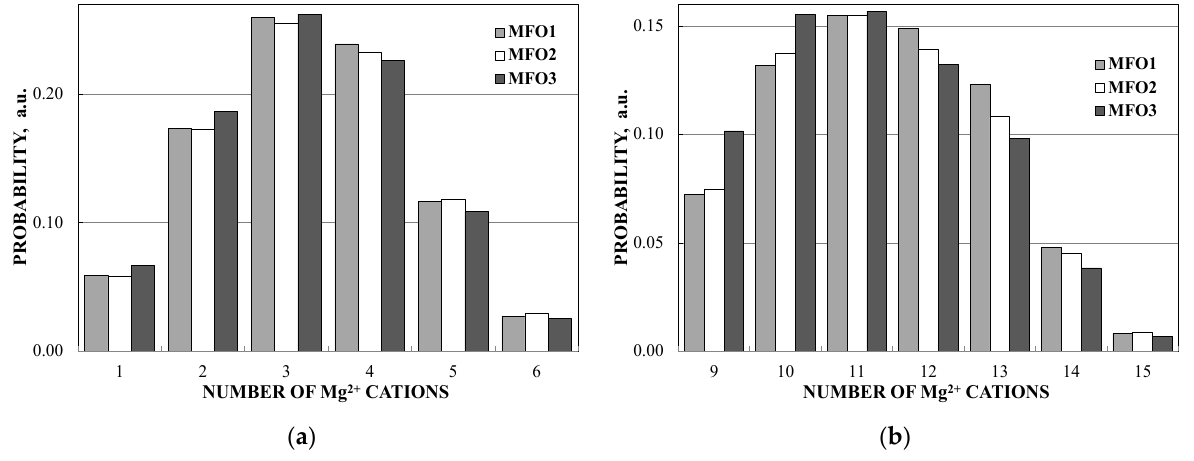
Figure 72. Histograms of the probabilities of different numbers of Mg 2+ cations in the Fe 3+A ( a ) and Fe 3+B ( b ) local microenvironments within the coordination sphere of 3.7 Å in the ideal MgFe 2 O 4 crystal with Fe and Mg compositions for MFO1, MFO2 and MFO3 samples. Adapted from Ref. [94] with permission from Elsevier: Journal of Alloys and Compounds, Vol. 912, Ushakov M.V., Nithya ©2022.